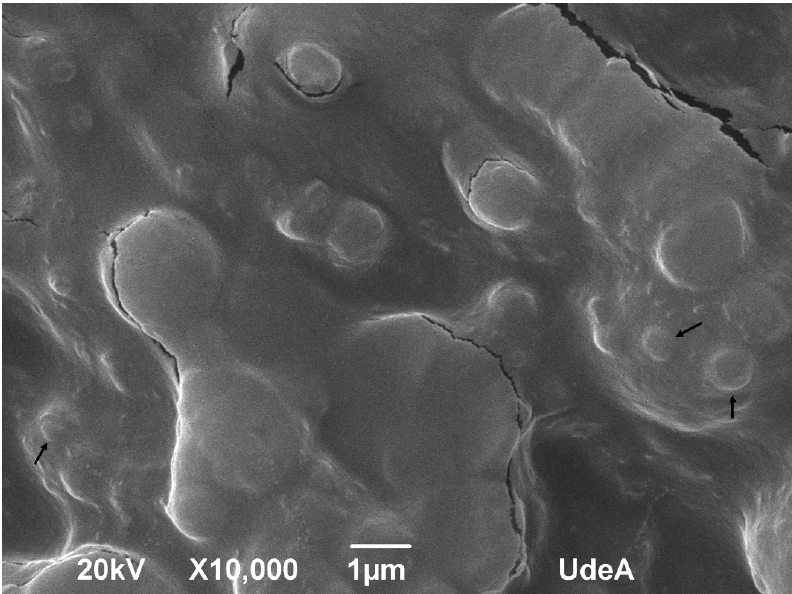
Figure 7. SEM image of polyelectrolyte nanoparticles based on AmCh:Pec HClpH2 .